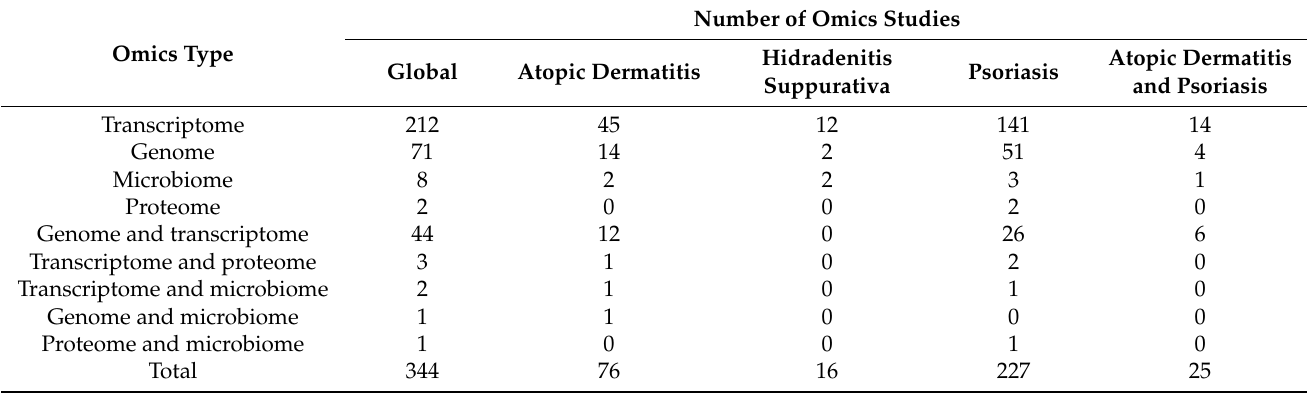
Table 5. Numbers of omics studies according to omics type and disorder with alterations in the Notch signaling pathway. Number of Omics Studies Omics Type Atopic Dermatitis Hidradenitis Psoriasis Global Atopic Dermatitis and Psoriasis Suppurativa Transcriptome 212 45